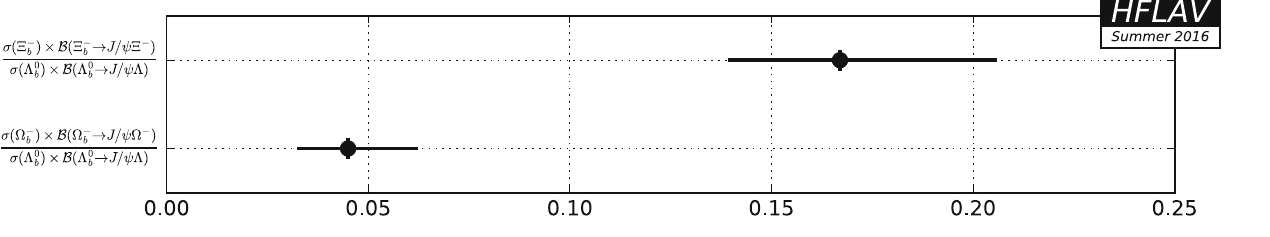
Fig. 171 Summary of the averages from Table 211